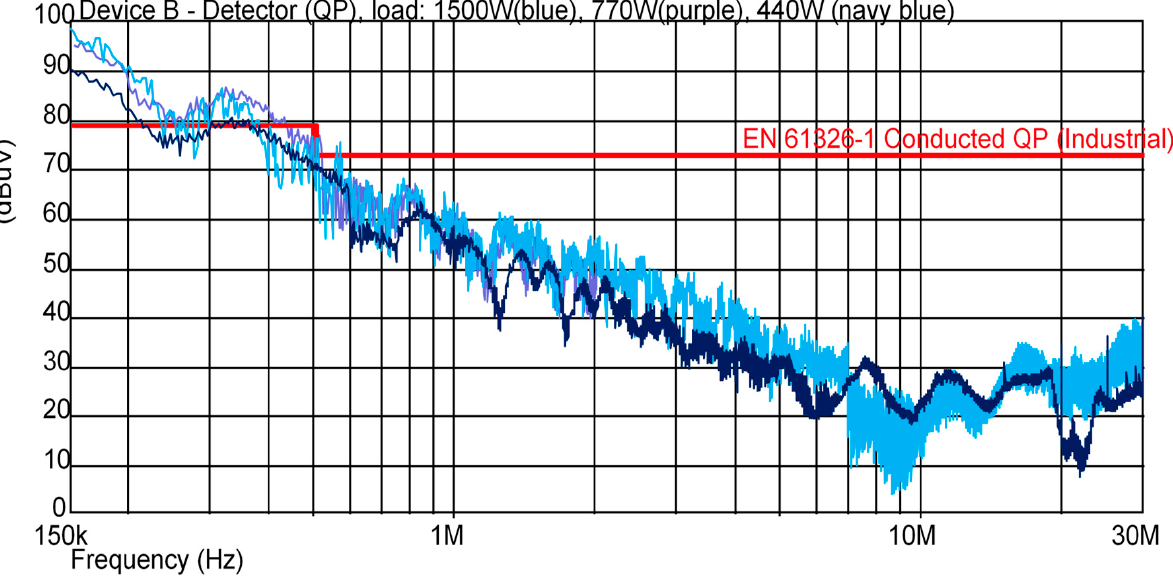
Figure 5. Frequency spectrum of conducted emission of the audio power amplifier (device B) measured for frequency of generated voltage by the device under test equal to 50 Hz and the values of the active load power equal to 1500, 770, and 440 W.